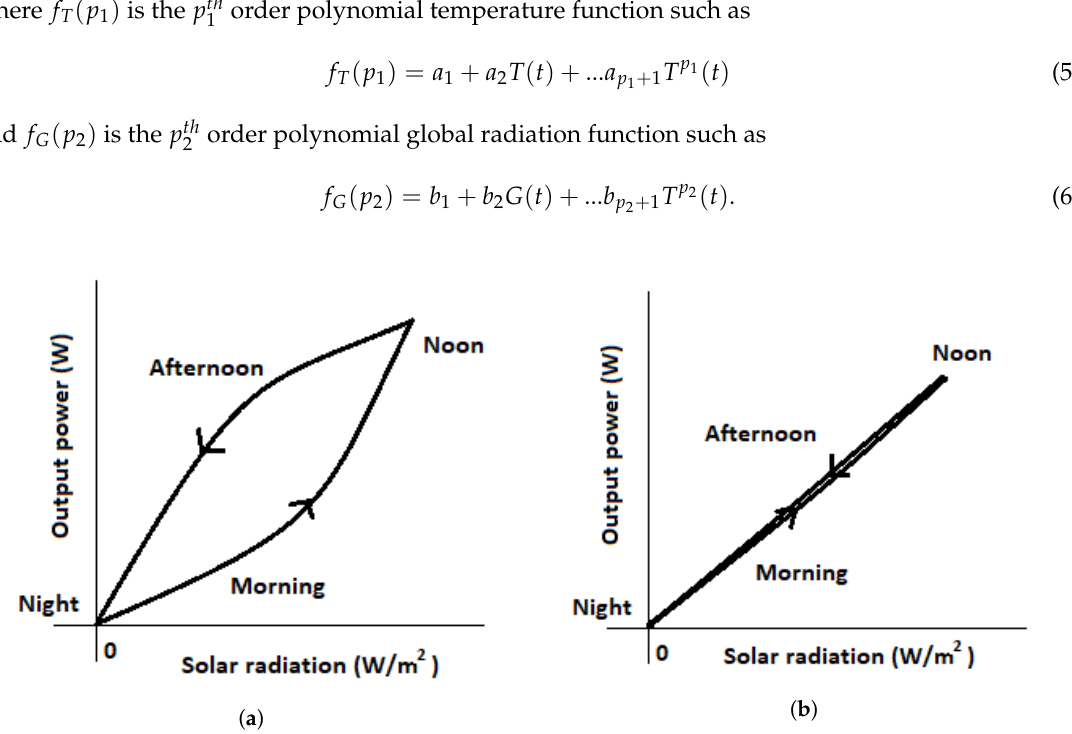
Figure 8. ( a ) Hysteresis curve; ( b ) Current, state of the art (classical) model.